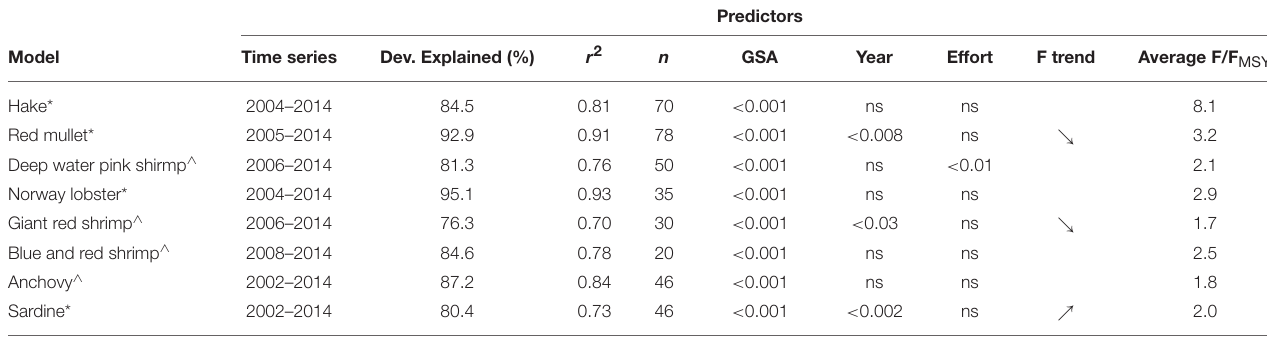
TABLE 4 | Results of the GAMs for each